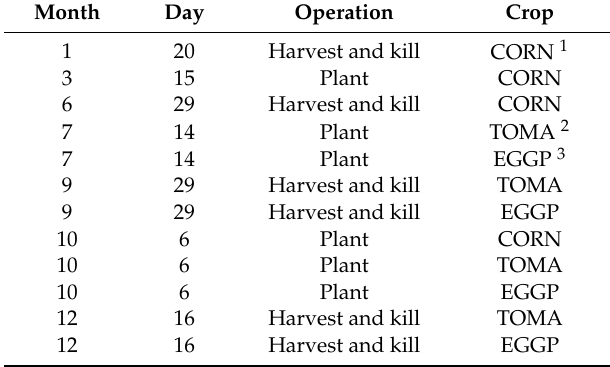
Table A1. Planting and harvesting schedule for the rainfed maize to irrigated mixed crops to irrigated mixed crops trajectory in SWAT + decision table.